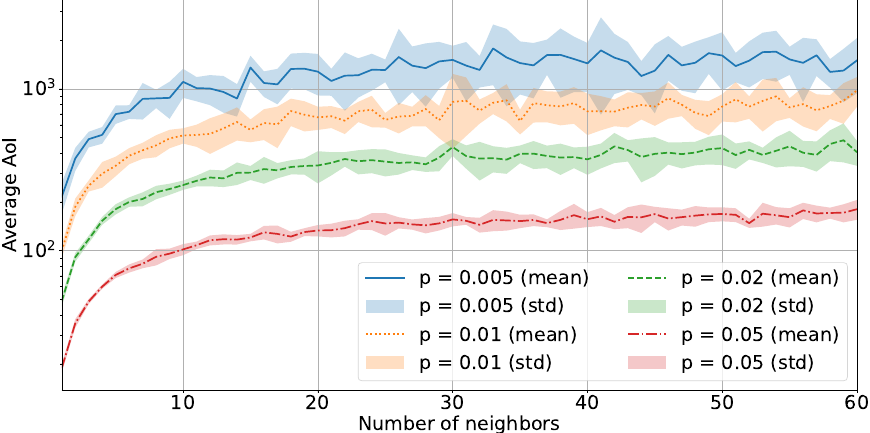
Figure 6. Average AoI with a variable number of neighbors in a strongly correlated scenario ( q = 0.1).